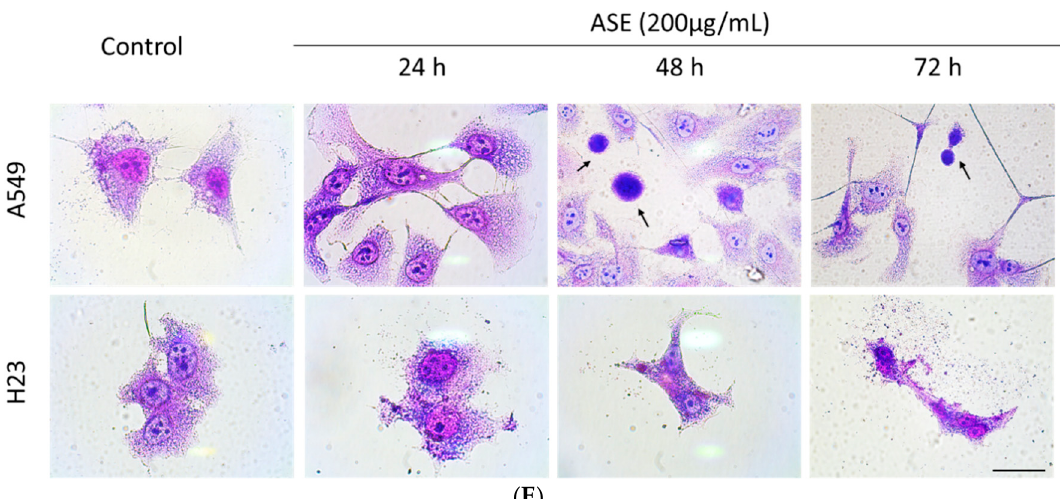
Figure 1. Effect of Artemisia santolinifolia ethanol extract (ASE) on cell growth of different non-small cell lung cancer (NSCLC) cell lines. Lung cancer cells were treated with different concentrations of the ASE for 24, 48, and 72 h. Cell viability of A549 ( A ) and H23 cells ( B ) was assessed by SRB assay. ( C ) The 50% inhibitory concentration (IC50) values were calculated at different time points. All data are the mean ± SE of three replicate experiments. ( D ) Light microscopic changes of cellular shape during ferroptosis. A549 and H23 cells were exposed for indicated durations to 200 μ g/mL ASE and observed by phase-contrast microscopy. Ferroptotic cells, presenting a typical rounded “balloon- ing” phenotype morphology, are indicated by red arrowheads. ( E ) Morphological changes after ASE treatment evaluated with Liu’s stain. Black arrows indicate a few examples of rounded, dying cells. Representative fields are shown. Scale bar = 50 μ m.